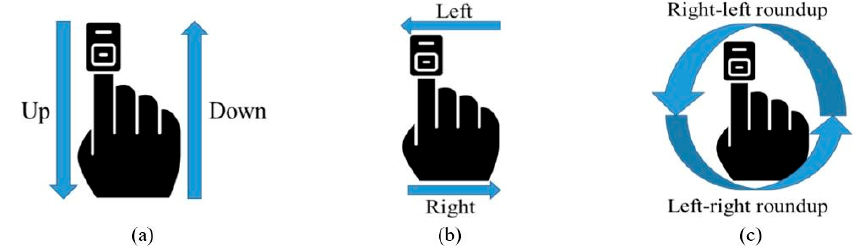
Figure 15. Three kinds of finger motion: ( a ) up ‐ down, ( b ) left ‐ right, and ( c ) round ‐ up.